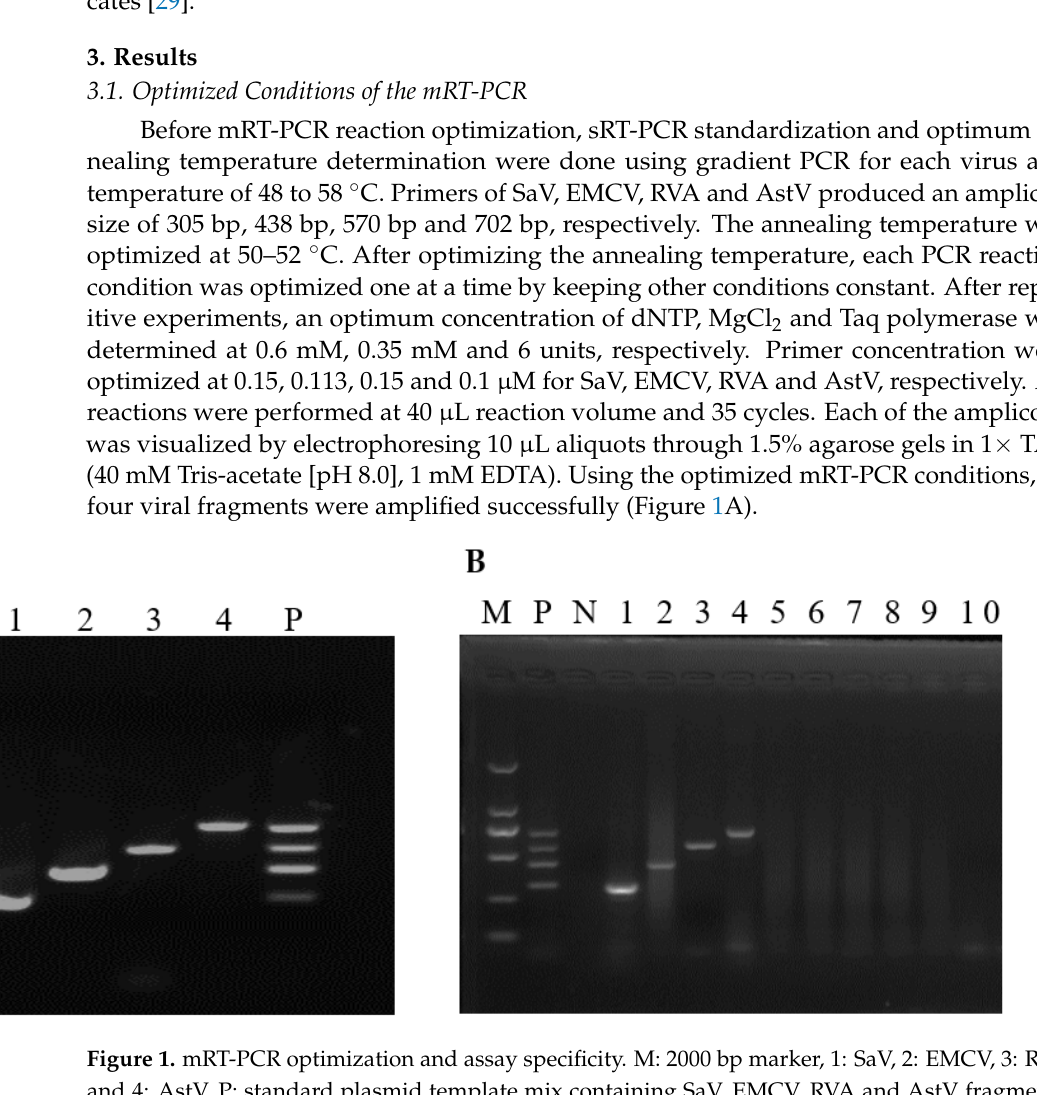
TGEV, PRRSV, PDCoV and PSV,